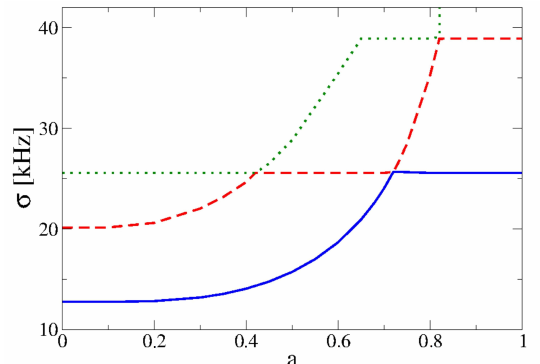
Figure 2. Frequencies of the modes 1 t 1 (solid blue), 1 t 2 (dashed red) and 1 t 3 (dotted green) as a function of a = R q / R CFL . As it is possible to see, we have two kind of features. There are oscillations whose frequencies depends on a and oscillations with frequencies independent of a [16].